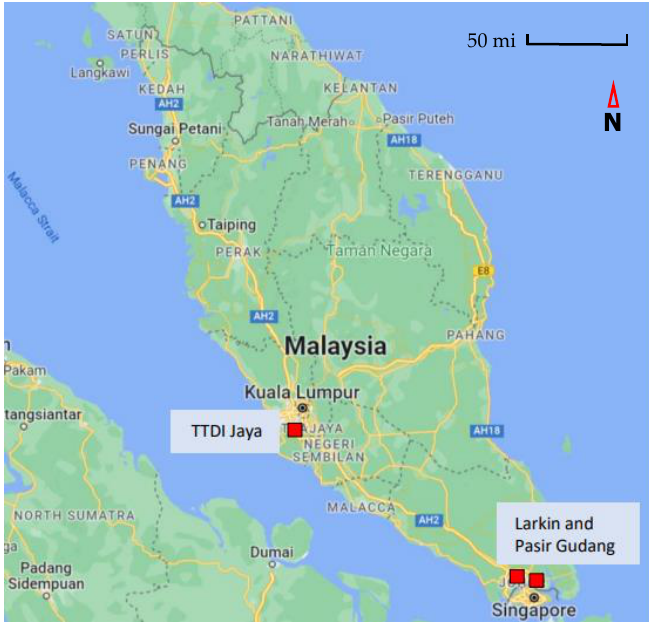
Figure 2. The location of the industrial areas.